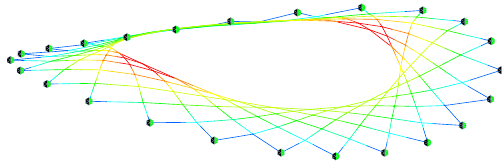
Figure 6. The first vibration mode (T = 1.8 s).